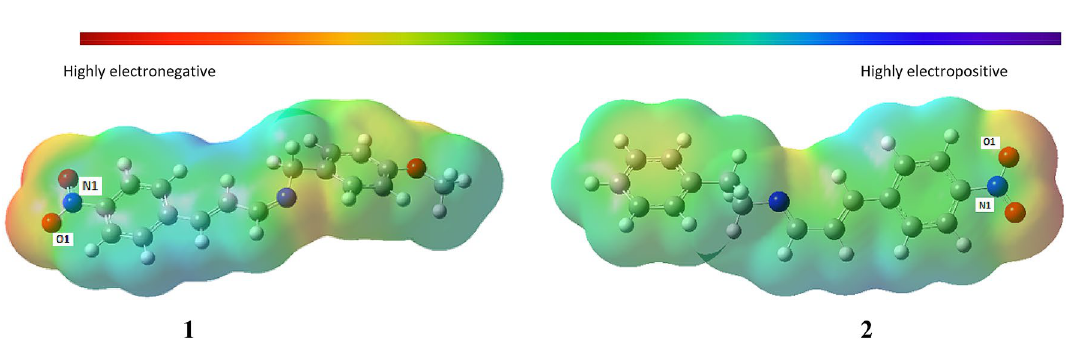
Figure 3. Molecular electrostatic potential (MEP) map of the